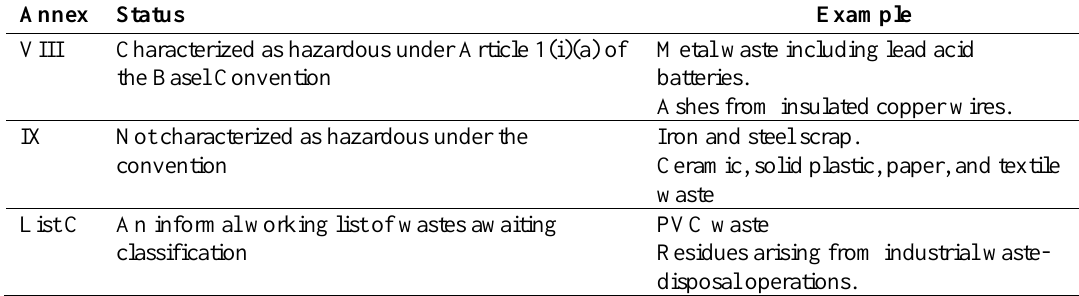
Table.1. Hazardous and Non-hazardous Wastes in the Basel